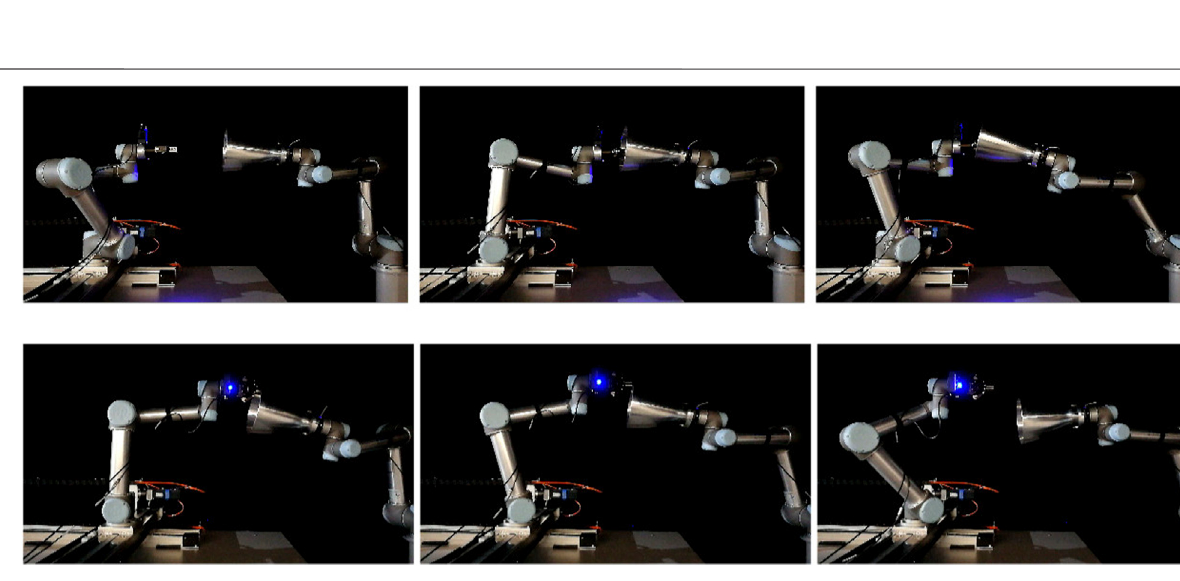
Frontiers in Robotics and AI |